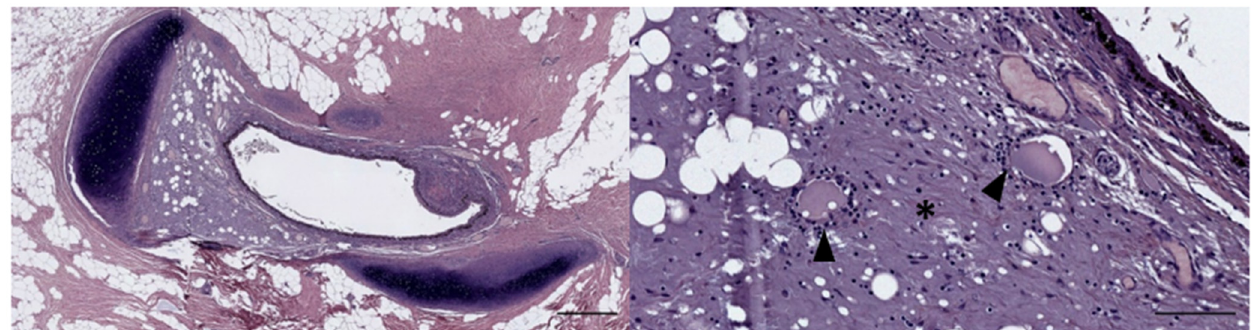
Table 2. An overview of the pathology findings and the number of cases.